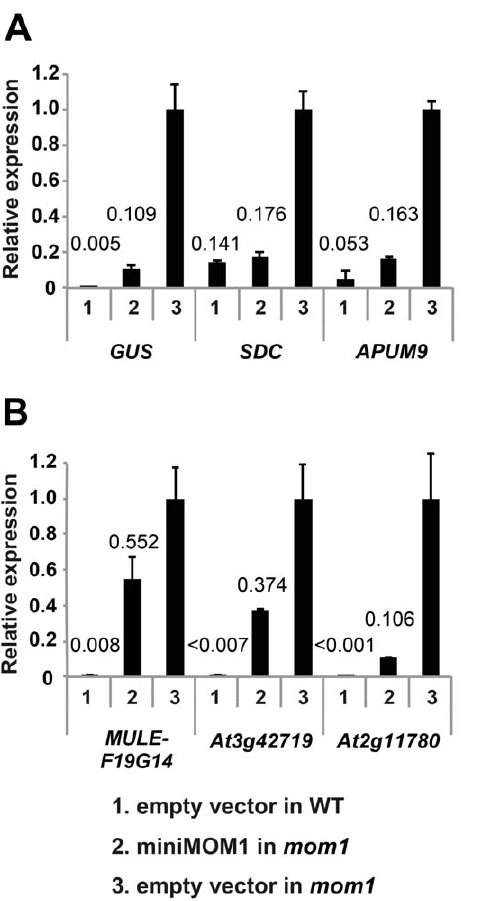
Figure 5. CMM2 acts selectively on MOM1-regulated TGS targets. Relative levels of mRNAs in T2 plants of various MOM1 target loci determined by quantitative RT-PCR and normalized to 18S rRNA. The targets regulated by MOM1 co-operatively with RdDM (A) and largely by MOM1 only (B) were investigated. These T2 plants were delivered from 3 independent T1 plants. The mean of ‘‘empty vector in mom1 ’’ was set to 1. The mean values of relative expression are indicated above columns. Error bars represent S.E. calculated from 3 experimental sets of 40 to 50 plants each.